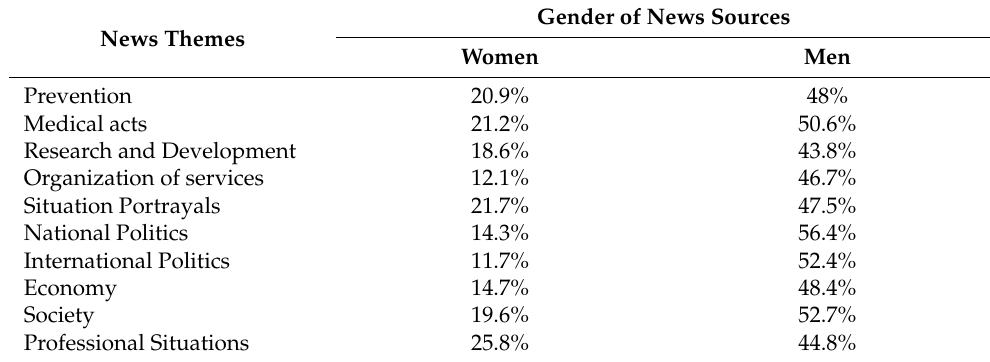
Table 2. Gender of news sources in relation to news themes